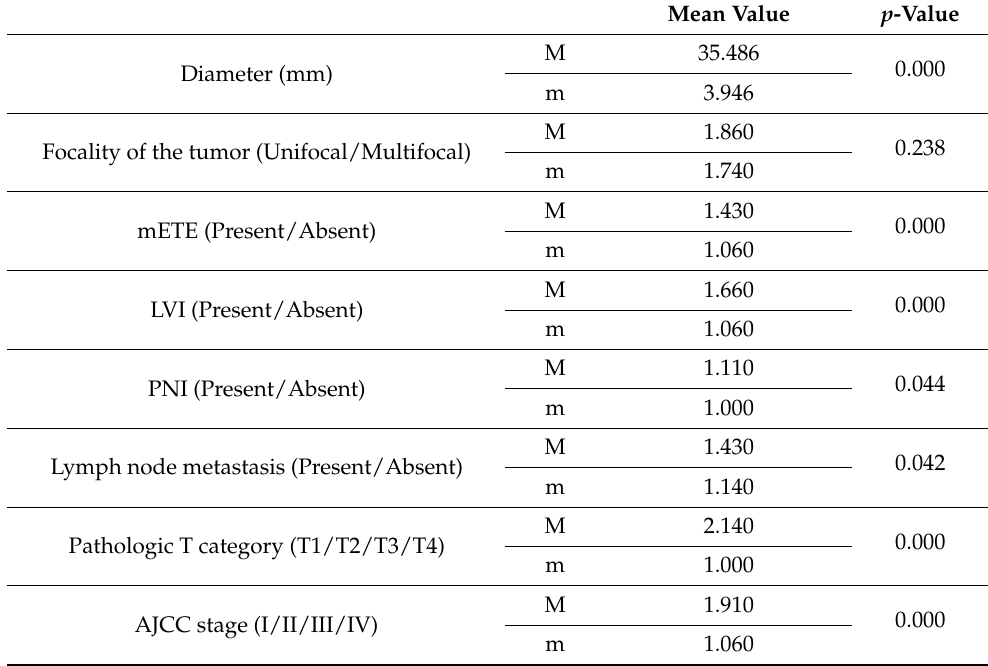
Table 2. Pathological characteristics of the TCTs’ main components compared to their minor compo- nents (Chi-squared test).